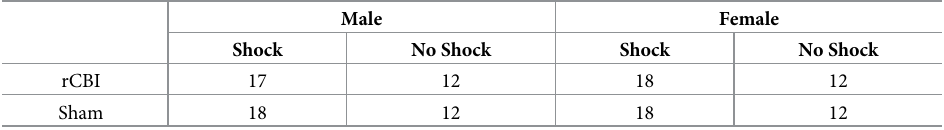
Table 1. Number of mice in each